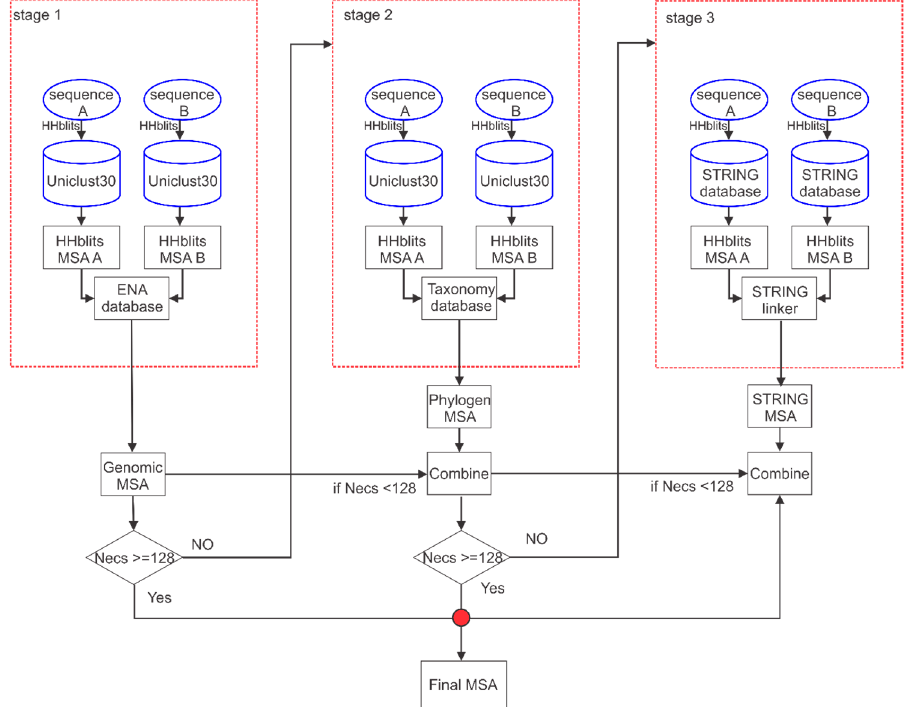
Figure 4. The flowchart of cpxDeepMSA. Three stages of MSA generations were performed consecutively using sequences from the HHblits search through Uniclust30 and pairing with genomic distance (first column), phylogeny information (second column), and the STRING interaction network (third column).